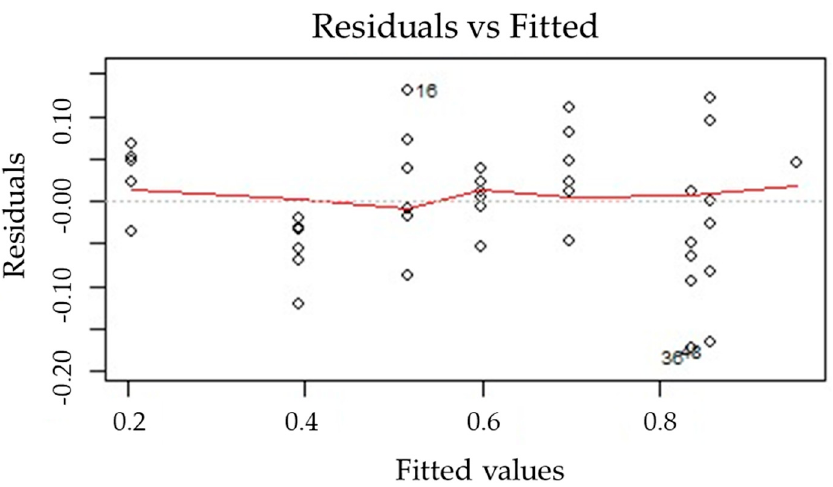
Figure A1. Quantile–quantile (Q–Q) plot of the residuals for the temperature-induced dose com- ponent model. The straight-line clustering suggests a normal distribution of the residuals of the fitted polynomial function.